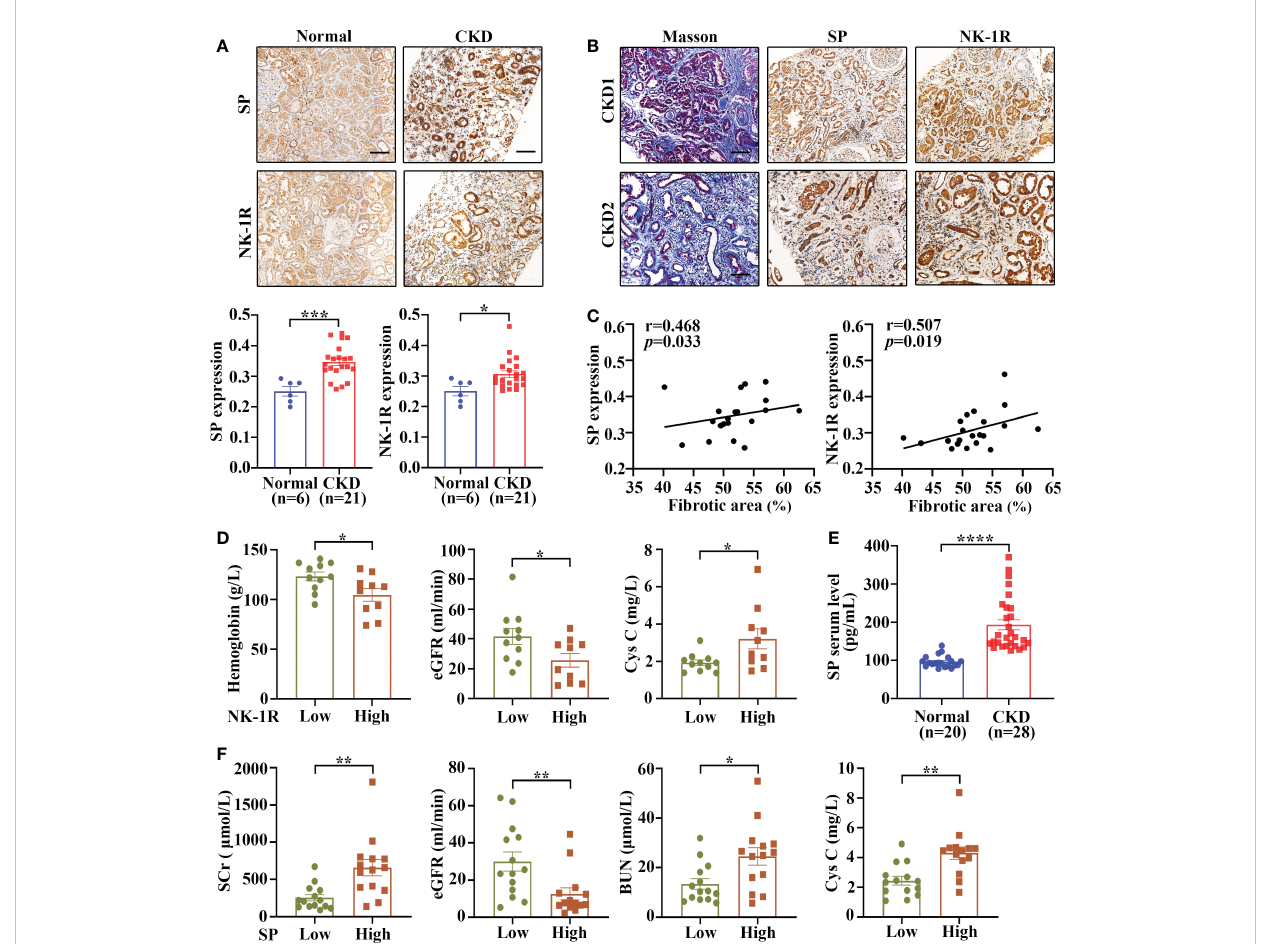
FIGURE 1 Renal SP/NK-1R and serum SP were up-regulated in patients with CKD and related to renal fi brosis and function. (A) The expression levels of NK-1R and SP were signi fi cantly increased in the fi brotic kidneys of patients with CKD, as assessed by immunohistochemistry staining. Representative sections (upper panels) and quantitative data (lower panels) are shown. (B, C) Spearman ’ s correlation coef fi cient analysis showed that the expression levels of renal NK-1R and SP were positively correlated with renal fi brotic extents in 21 CKD individuals. Representative sections of immunohistochemistry staining and Masson ’ s trichrome are exhibited in (B) . (D) Correlation between clinical characteristics and high/low renal expression of NK-1R in 21 CKD patients. The median NK-1R level was selected as the cut-off value for separating high from low NK-1R expression groups. (E) ELISA analysis displayed increased serum SP levels in CKD patients. (F) Correlation between clinical characteristics and high/low serum SP levels in 28 CKD patients. Samples were classi fi ed into high and low SP level groups using the cutoff of median SP level. Scale bar, 100 µm. Data are shown as mean ± SEM. * p < 0.05; ** p < 0.01; *** p < 0.001; **** p <